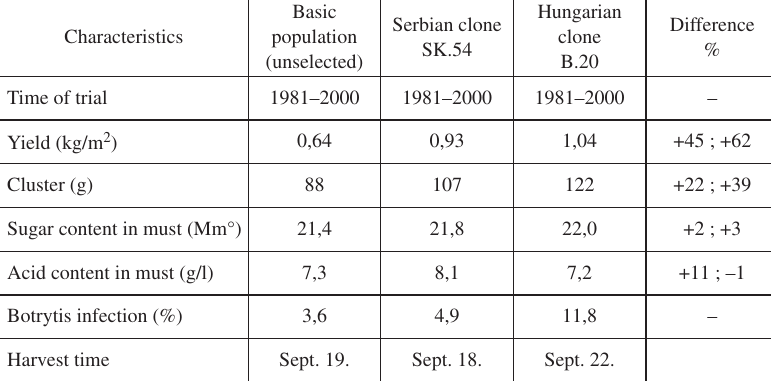
Table 3. Performance of “Pinot gris” clones